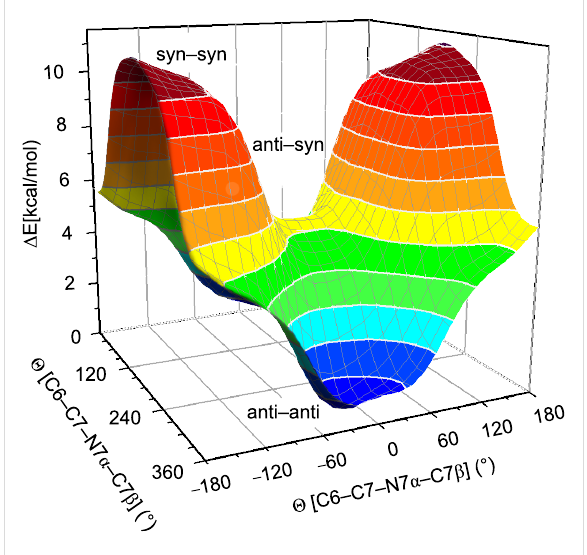
Figure 5: Surface plot of the relative potential energy of 1 as a func- tion of the two constitutive [C6–C7–N7 α –C7 β ] torsion angles. Indi- vidual geometries were optimized at the B3LYP/6-311+G(d,p) level of theory at 30°